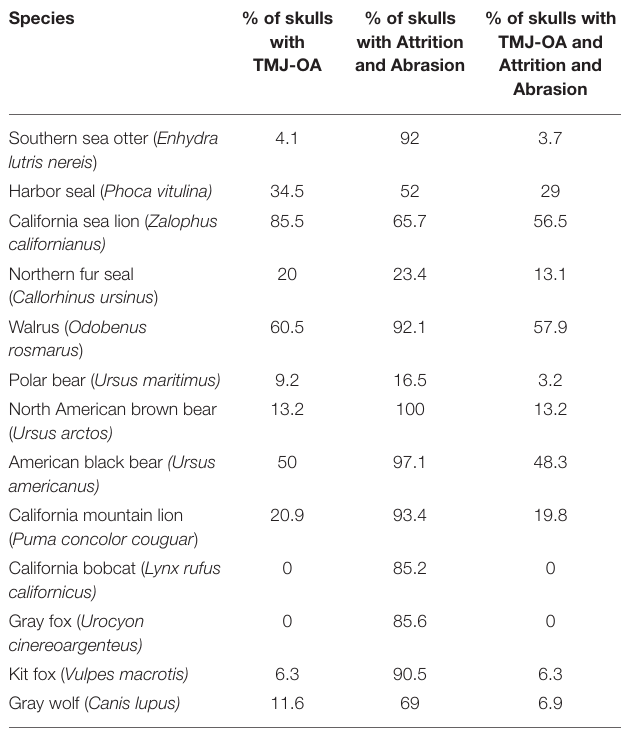
TABLE 1 | Percentage of skulls with TMJ-OA, attrition and abrasion, and skulls with both pathologies present.